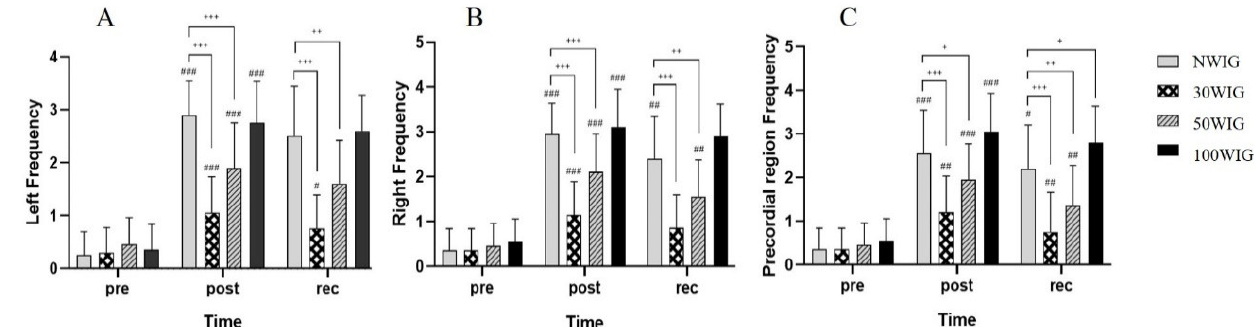
Figure 1. Comparison of frequency in the left subclavian vein ( A ), right subclavian vein ( B ) and the precordial region ( C ). Following ANCOVA, Bonferroni post hoc analysis was conducted to specify protocol effect. NWIG, no-water-intake group; 30WIG, 30%-water-intake group; 50WIG, 50%-water-intake group; 100WIG, 100%-water-intake group. The data are represented as mean ± SD. *, **, and *** represent p ≤ 0.05, p ≤ 0.01, and p ≤ 0.001, respectively, when compared to NWIG at post-dive (post). # , ## , and ### represent p ≤ 0.05, p ≤ 0.01, and p ≤ 0.001, respectively, when compared to NWIG at 30 min into recovery time (rec).